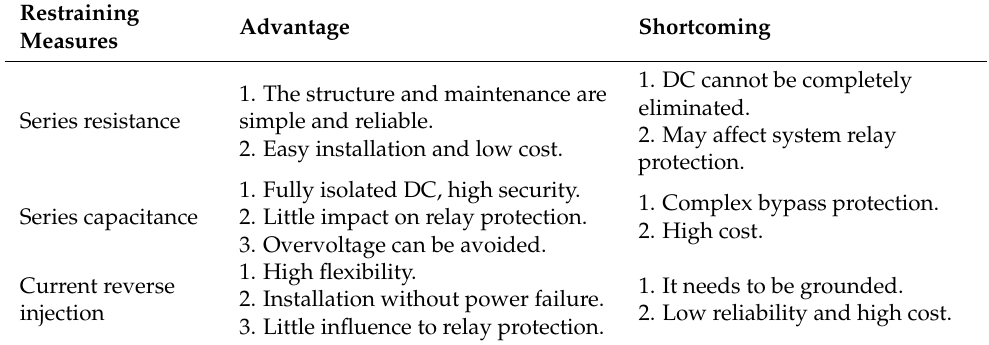
Table 1. Comparison of advantages and disadvantages of each inhibition